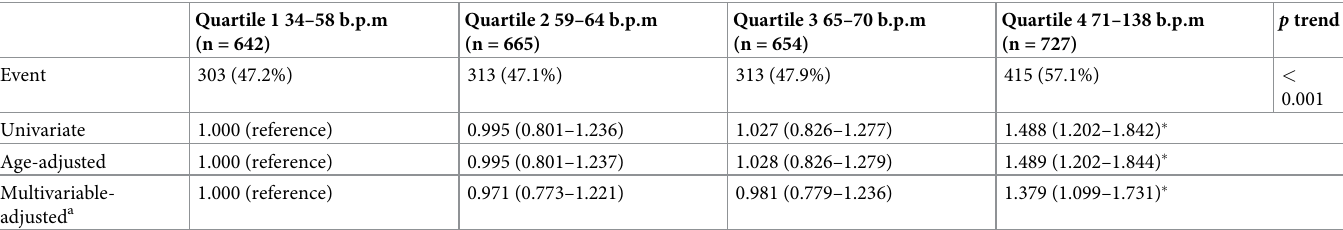
Table 3. Advanced adenoma development rates according to resting heart rates.